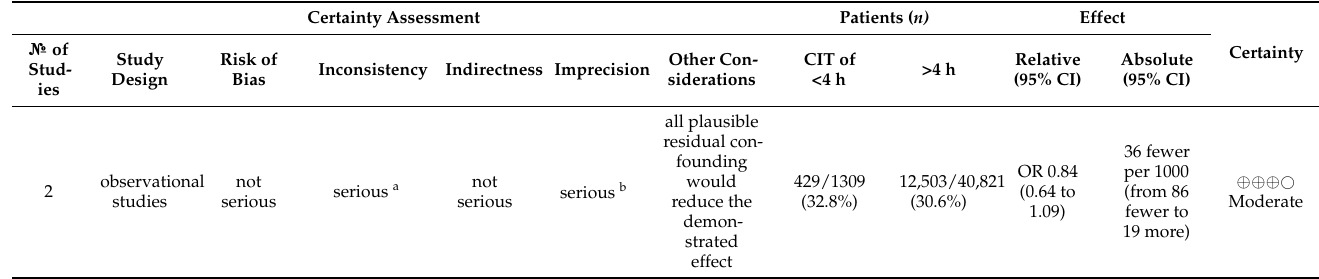
Table A8. Summary of findings with the level of evidence estimated by the Grade-tool for 10-years graft